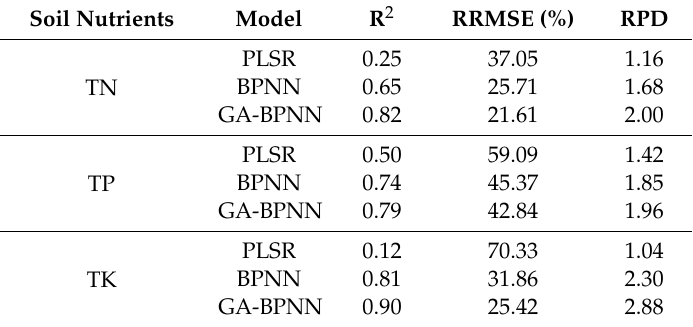
Figure 8. The scatter plots of the predicted versus measured soil nutrient contents (TN, TP and TK) using the validation dataset. Table 3. The prediction accuracies of soil nutrient contents using PLSR, BPNN and GA-BPNN methods based on the validation dataset (R 2 : coefficient of determination; RRMSE: relative root mean square error; RPD: ratio of performance to deviation).